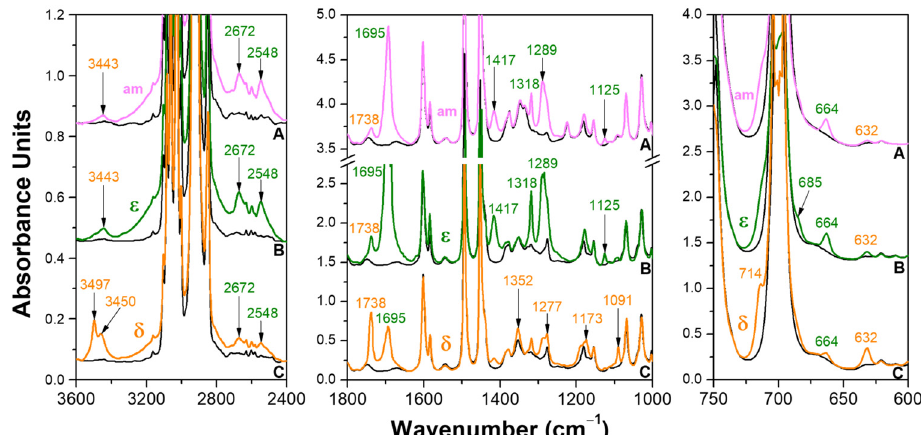
Figure 2. FTIR spectra, for three spectral ranges (3600–3200 cm − 1 , 1800–1000 cm − 1 and 750–600 cm − 1 ) of axially oriented sPS films before (black lines) and after BA sorption (colored lines): ( A ) zig-zag planar mesomorphic; ( B ) NC ε form; ( C ) NC δ form. Peaks due to the isolated and dimeric BA molecules are labeled by orange and green numbers, respectively. Table 1. FTIR peaks of BA dimers as observed for solid BA (KBr pellets [35] or mull [36]) and for BA guest molecules in axially stretched ε -form sPS and α -form PPO films.